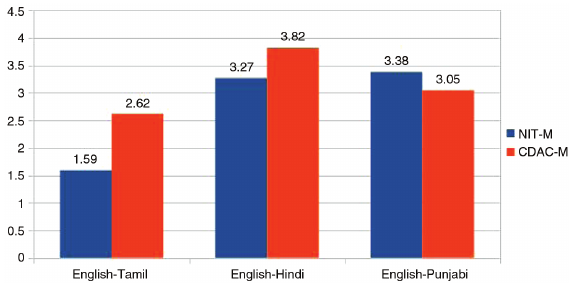
Figure 3: Comparison of Adequacy Scores of NIT-M and CDAC-M